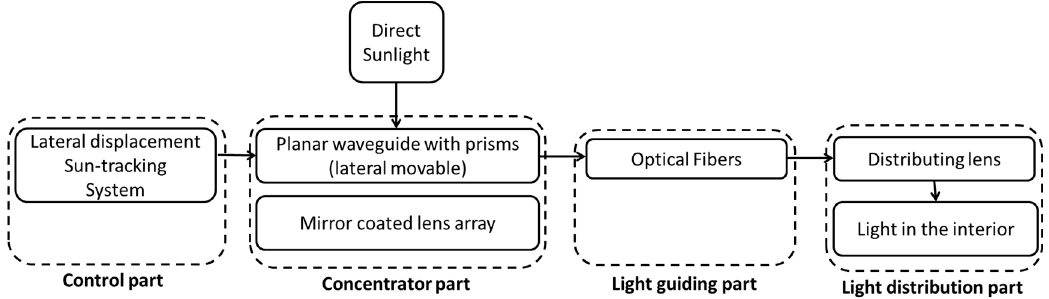
Figure 2. Flow chart of the proposed flat OFDS.